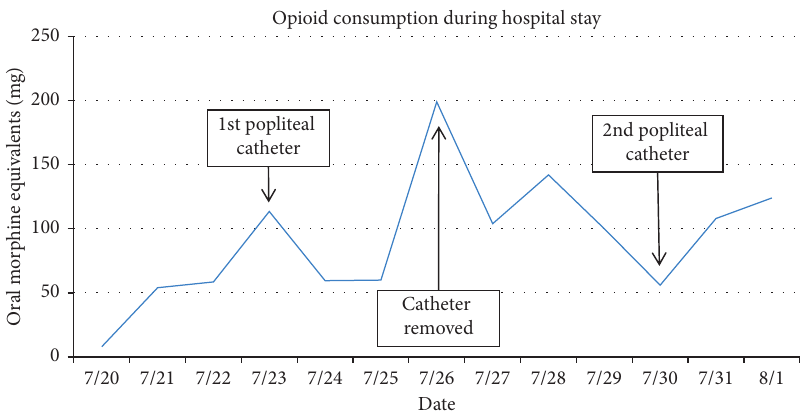
Figure 2: Opioid consumption during hospital stay. The line graph displays oral morphine equivalents (in mg) consumed for each hospital day. A peak of 200 OME was observed on 7/26 when the catheter was removed.